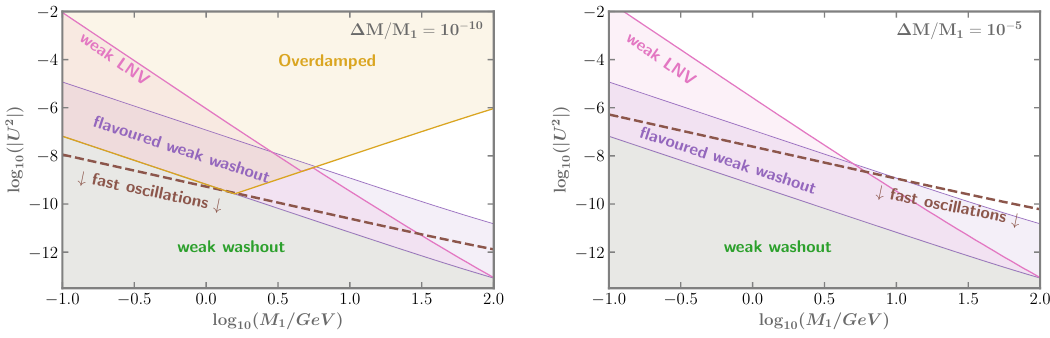
Figure 1 . Boundaries of washout regimes and regions described in the text on the plane | U | 2 versus M for two choices of ∆ M/M